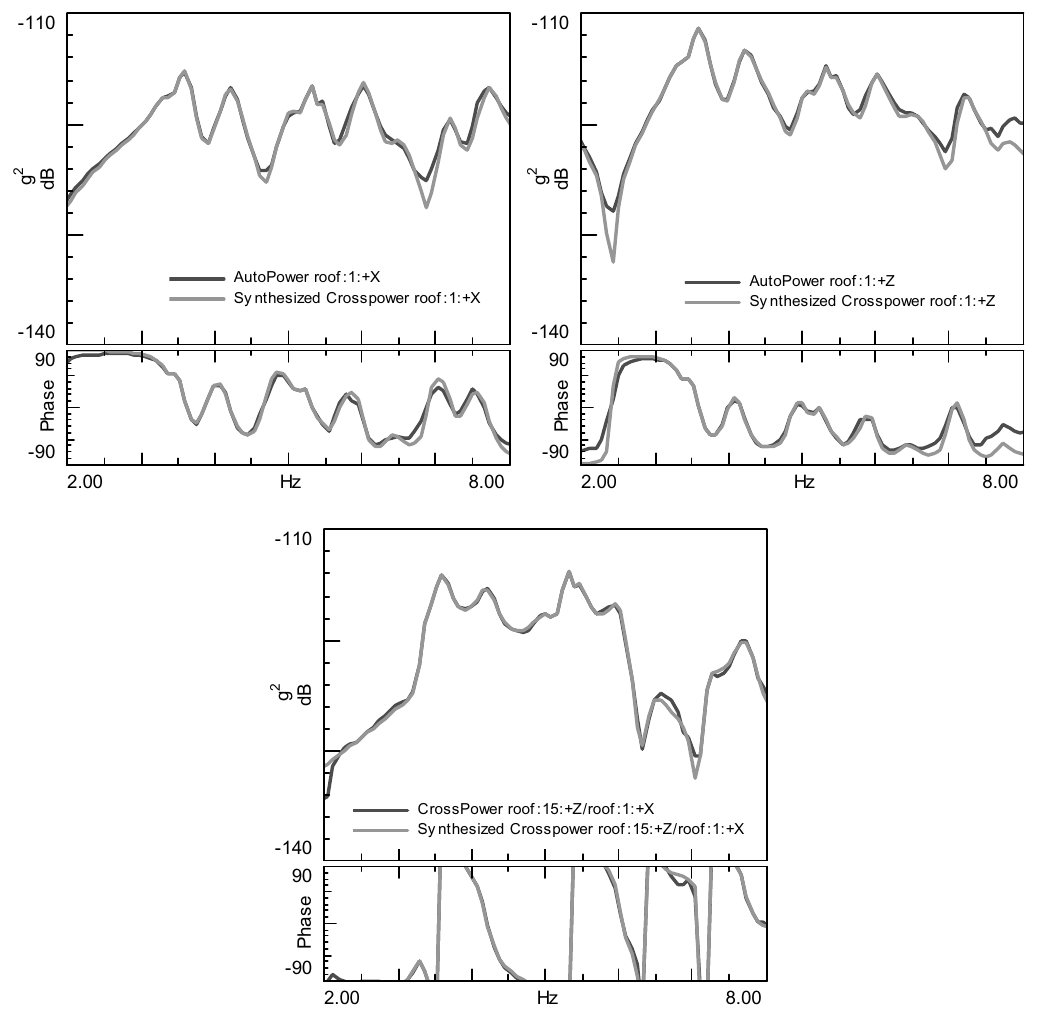
Fig. 11. Empty stadium: Measured (red/black) versus synthesised PolyMAX spectra